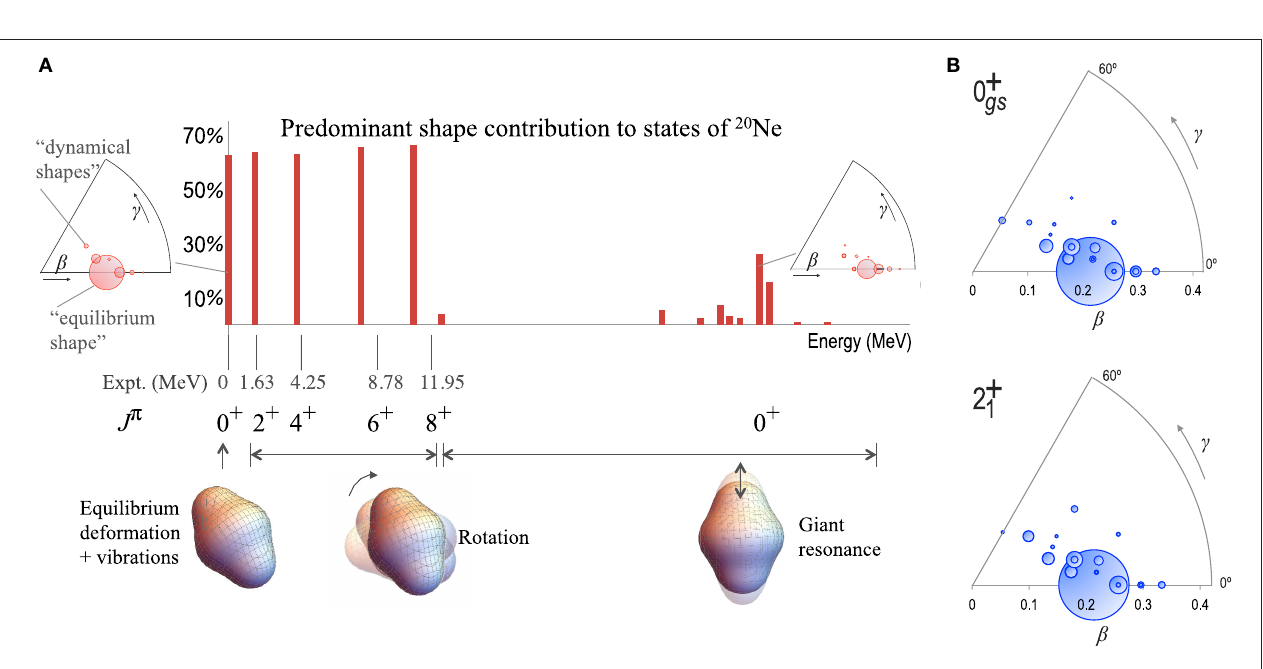
FIGURE 14 | SA-NCSM results for 20 Ne in an SU(3)-adapted basis, using the two-nucleon interaction [264]. (A) Excitation energies (horizontal axis) of the ground-state rotational band ( J π = 0 + through 8 + ) and 0 + states, and the dominant shape in each state (vertical axis), indicated using the ab initio one-body density profiles in the intrinsic (body-fixed) frame. (B) Distribution of the equilibrium shapes that contribute to the ground state and first excited 2 + state, indicated by the average deformation parameters ( β , γ ). See reference [140] for additional details. Figure reprinted with permission from the American Physical Society.